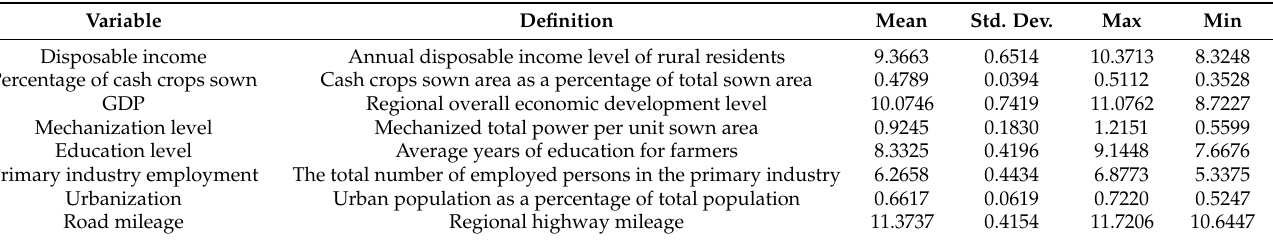
Table 1. Variable descriptions and descriptive statistics.